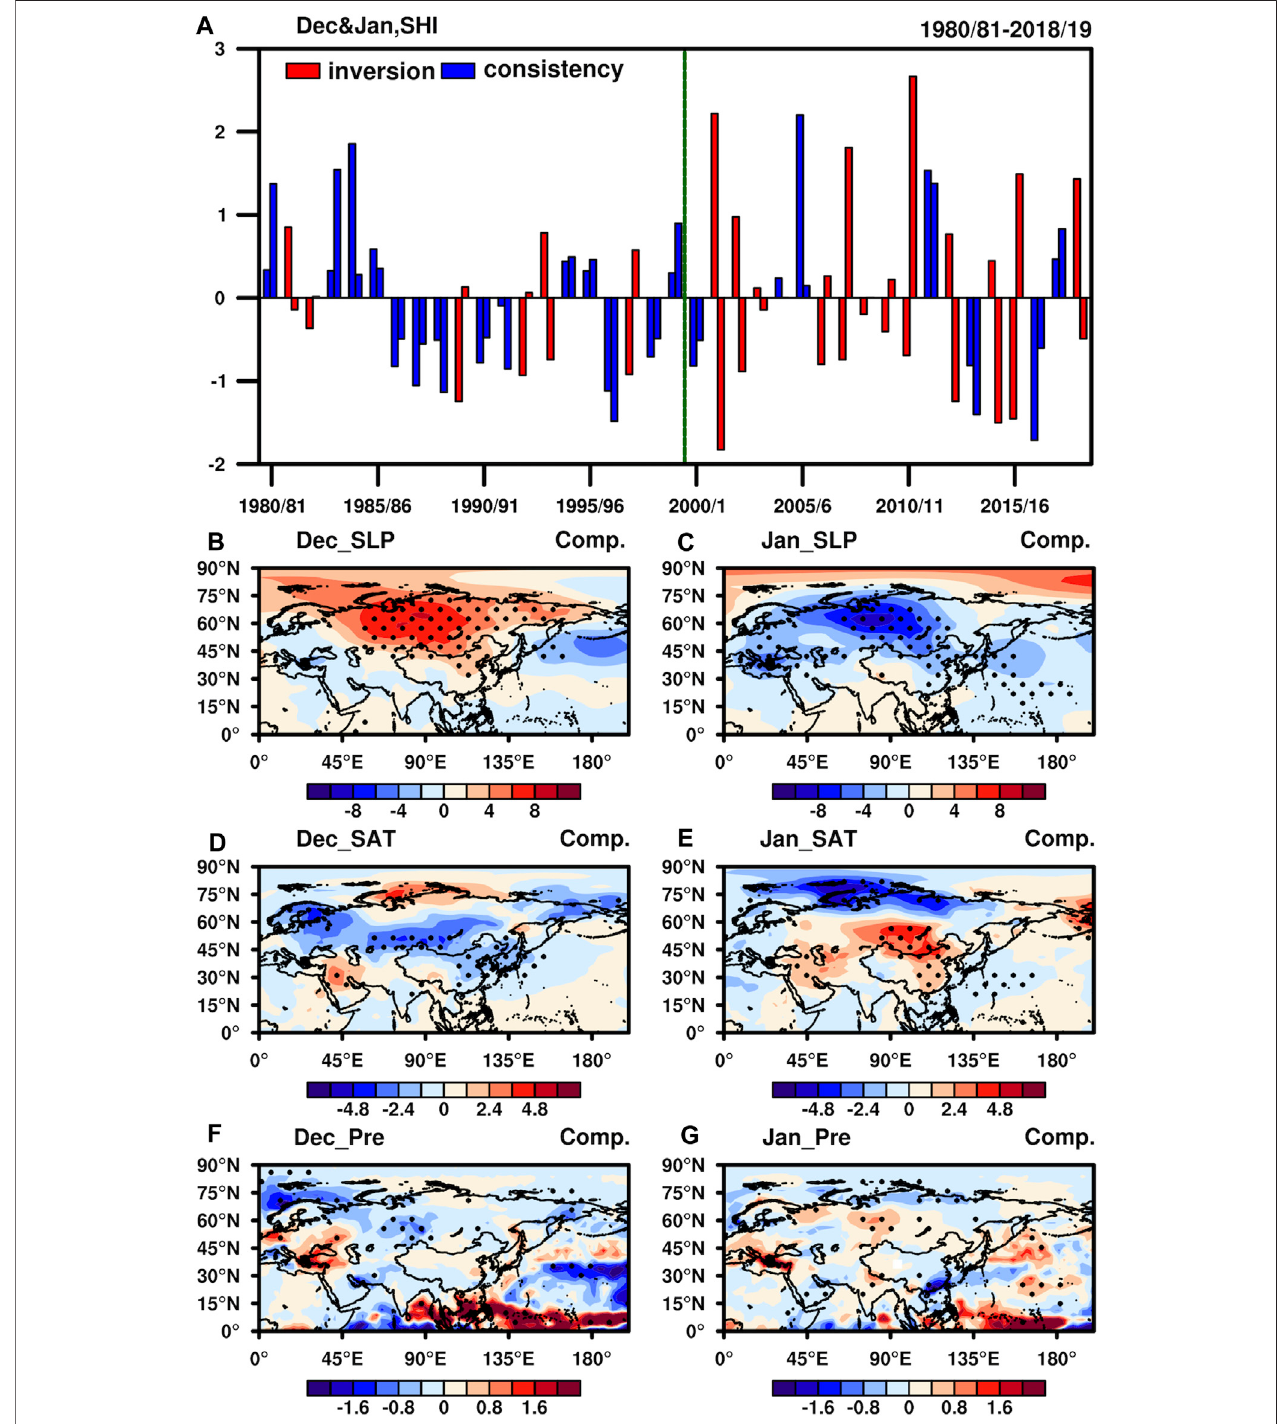
FIGURE1|(A) Siberianhigh intensity index(SHI) ineach midwintermonth (December, January) during1980/81 – 2018/19. Compositespatialpatternsofvariables betweenSH + − andSH − + for(B,D,F)Decemberand(C,E,G)Januaryduring1980/81 – 2018/19: (B,C) sealevelpressure(SLP,units:hPa); (D,E) surfaceairtemperature (SAT, units: ° C); (F, G) precipitation (units: mm/day). Years of other reversal types of SH are shaded by red bars, and consistent types are shaded by blue bars in (A). Dotted regions in (B – G) are statistically signi fi cant at the 90% con fi dence level, based on the t -test.